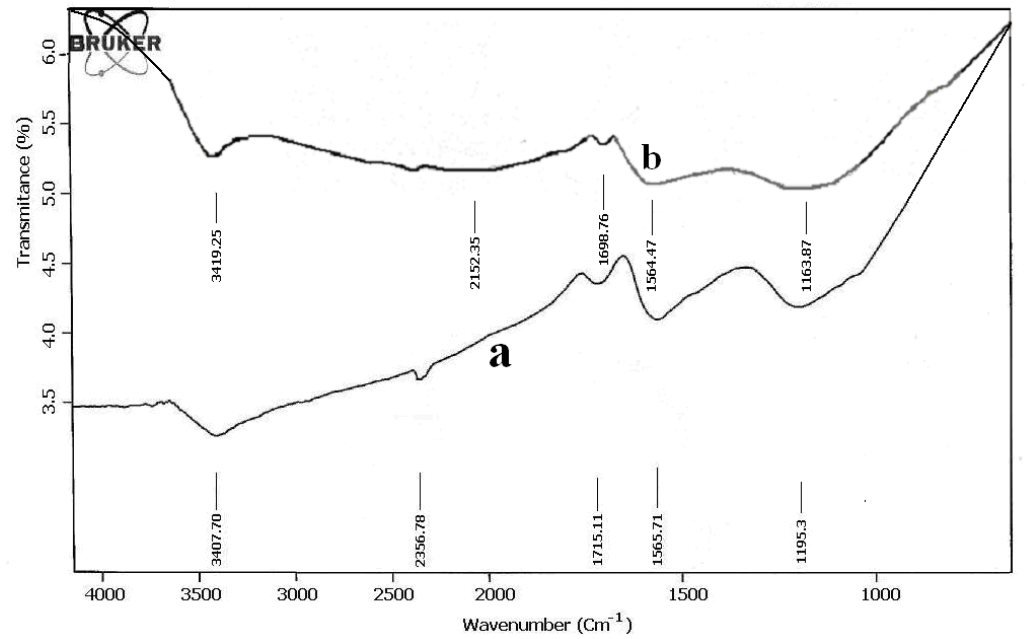
Figure 3. Fourier transforms infrared spectra of (a) PASAC and (b)